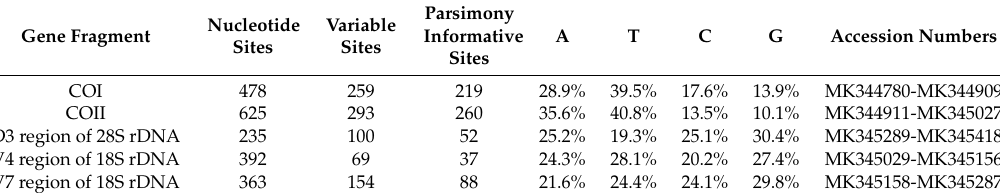
Table 2. The information on gene fragment composition.